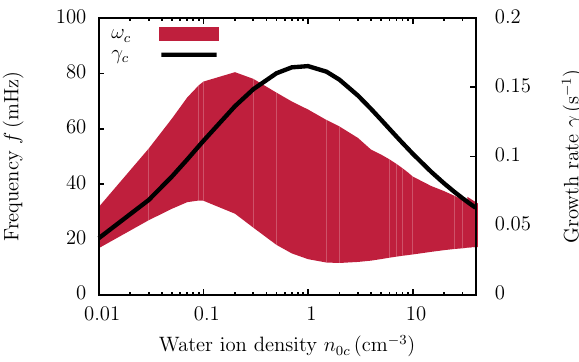
Figure 10. Variation of the frequency range of ω c (red) regarding the ambient magnetic field B 0 for wave propagation close to the di- rection with maximum growth rate ( 86 ◦ (cid:46) φ (cid:46) 106 ◦ ) in CSEQ. The gyro-frequency of protons (cid:127) p (blue) is shown for comparison. A close-up view around the default magnetic field is shown in the in- laid panel.